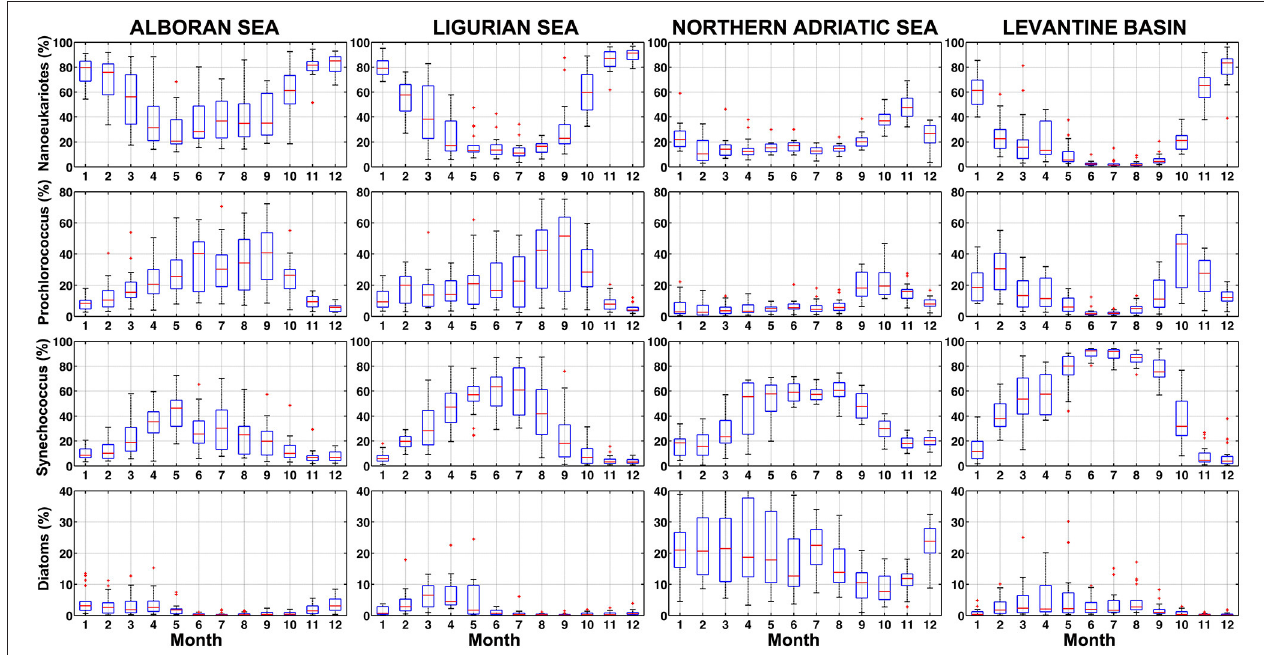
FIGURE 10 | Box plot for monthly climatology for each group in Mediterranean sub-regions. Each row represents each phytoplankton group (nanoeukaryotes, Prochlorococcus , Synechococcus, and diatoms) and each column corresponds to the same sub-region (Alboran Sea, Ligurian Sea, Northern Adriatic Sea, and Levantine Basin). In the box plot figure red lines stand for the median, blue box spans from the first to the second quartiles, and black lines represent 5th and 95th percentiles, respectively, of monthly climatology for each group.